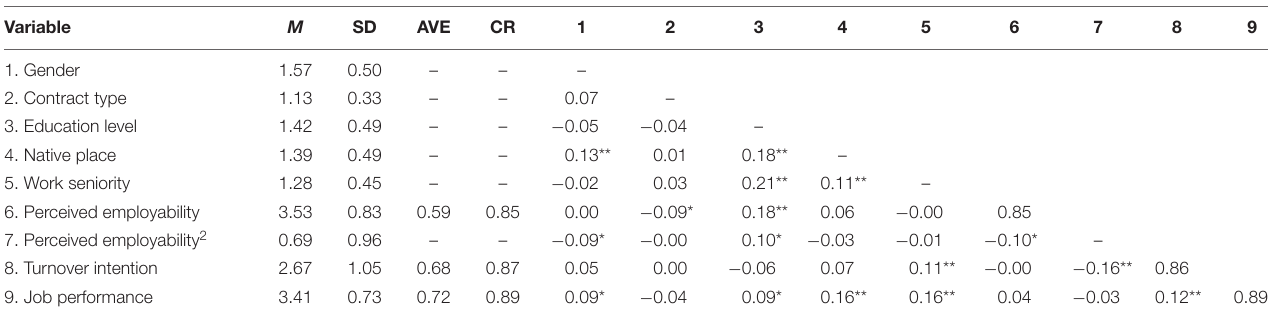
TABLE 1 | Means, standard deviations, correlations, and internal consistency reliabilities.